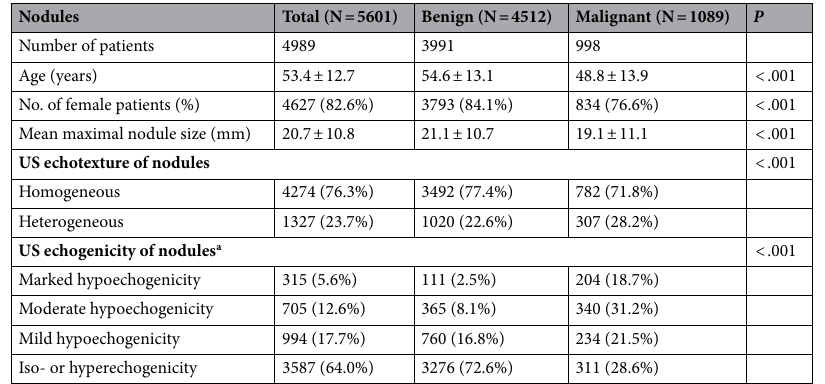
Table 1. Demographic Data of 5601 Nodules in This Study. Unless otherwise indicated, data are numbers with percentages in parentheses for categorical variables. a Determined by the predominant echogenicity in nodules with heterogeneous